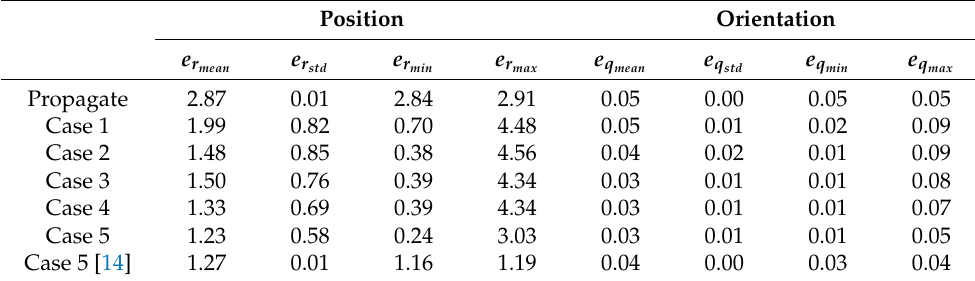
Table 4. Position (m) and quaternion error statistics of vehicle 1 across 100 simulations for Scenario 1. Position Orientation e r e r mean std